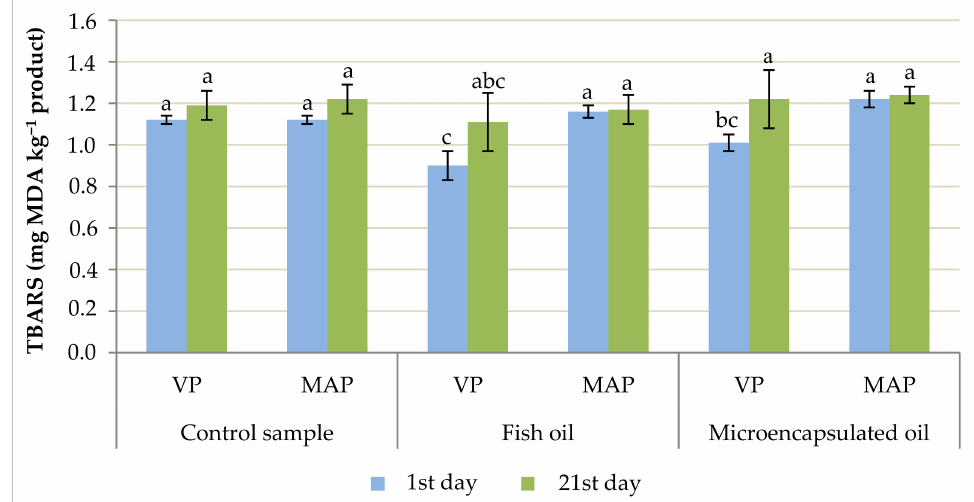
Figure 1. The effect of the liquid and microencapsulated fish oil additive, packaging method and storage time on the oxidative stability of the poultry sausages. a–c = The mean values with the same superscript are not significantly different ( p < 0.05; mean ± standard deviation; n =